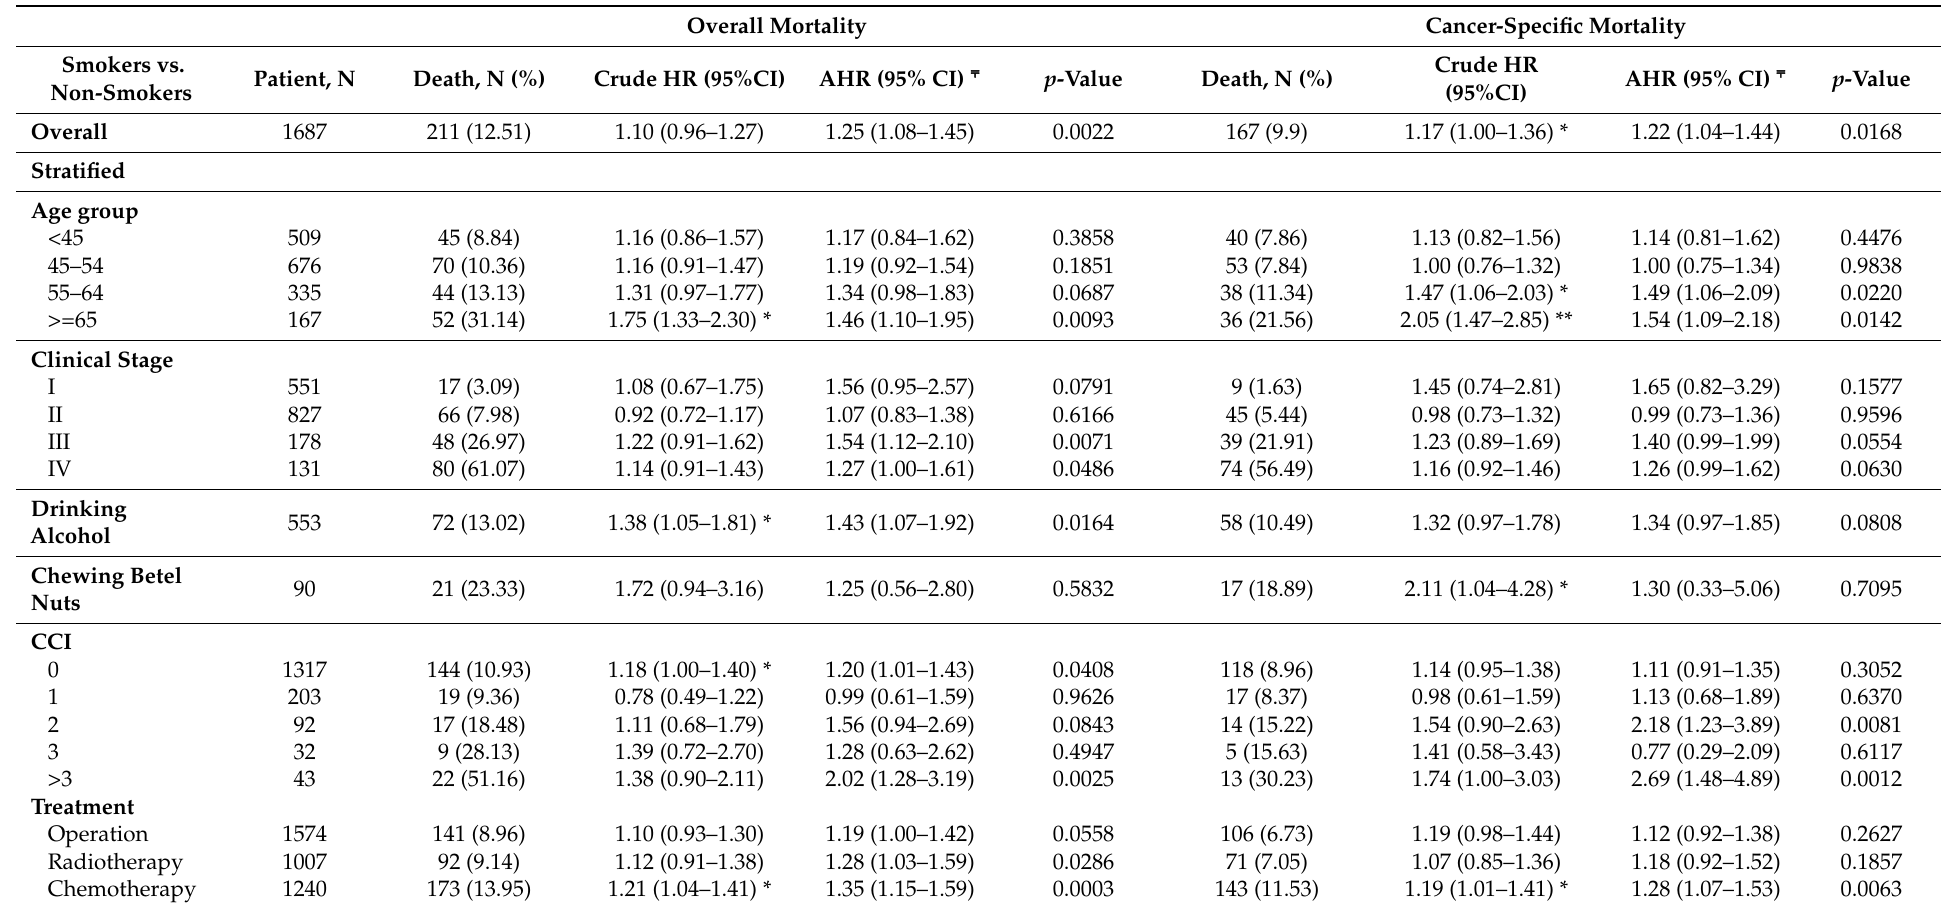
Table 2. The risk of mortality between smokers and non-smokers among women with breast cancer stratified by characteristics. Overall Mortality Cancer-Specific Mortality Smokers vs.